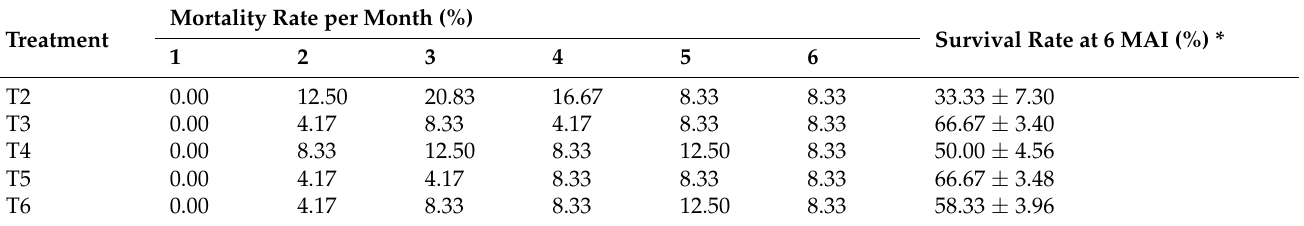
Table 12. Mortality rate per month and survival rate of rubber seedlings pretreated with Trichoderma suspensions ( Trichoderma asperellum + Trichoderma spirale ) or propiconazole after inoculation with Rigidoporus microporus for six